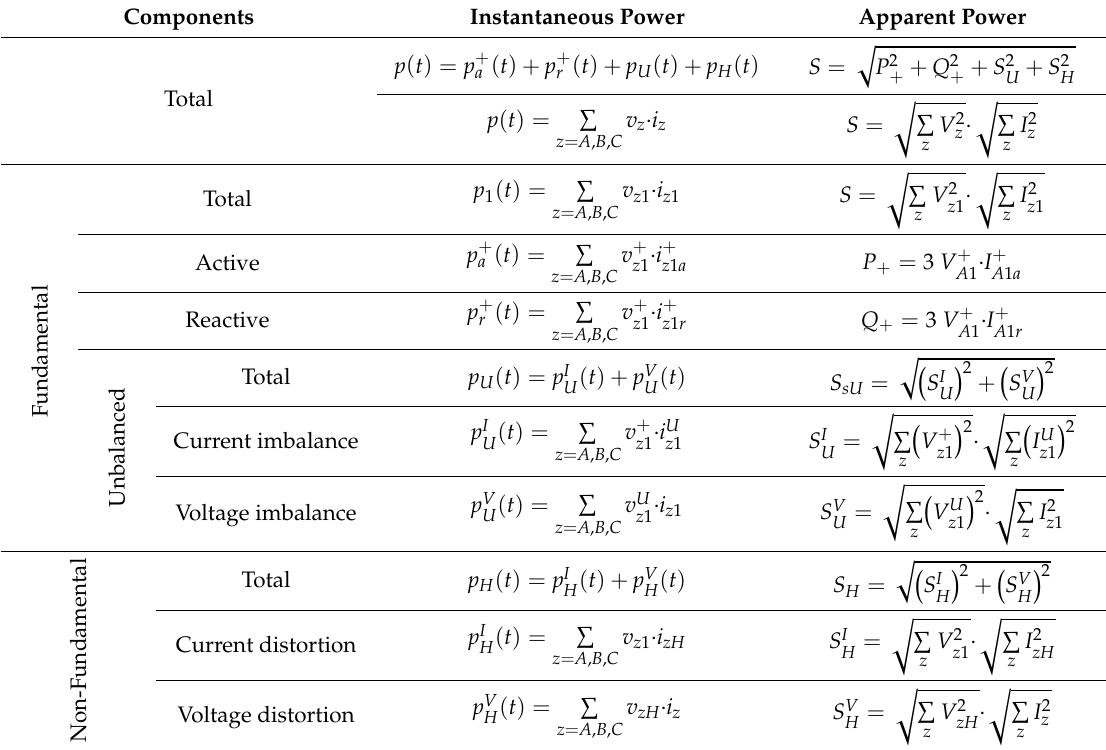
Table 1. Summary of the instantaneous and apparent power expressions and their components in three-phase sources and loads according to our proposed